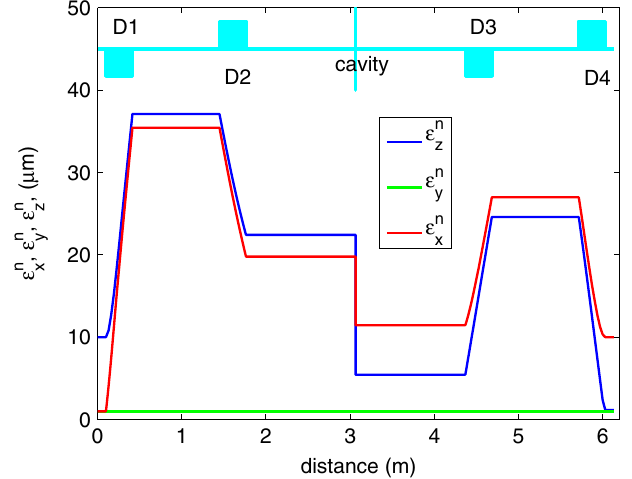
FIG. 3. Evolution of the transverse horizontal (blue), longitu- dinal (green), and vertical (red) emittances along the EEX beam line with parameters given in Table I. The cyan symbols indicate the axial locations of the four dipoles (shown as rectangles and labeled D i ) and deflecting cavity (vertical line at s ’ 3 m ). The initial normalized emittance partition is ð